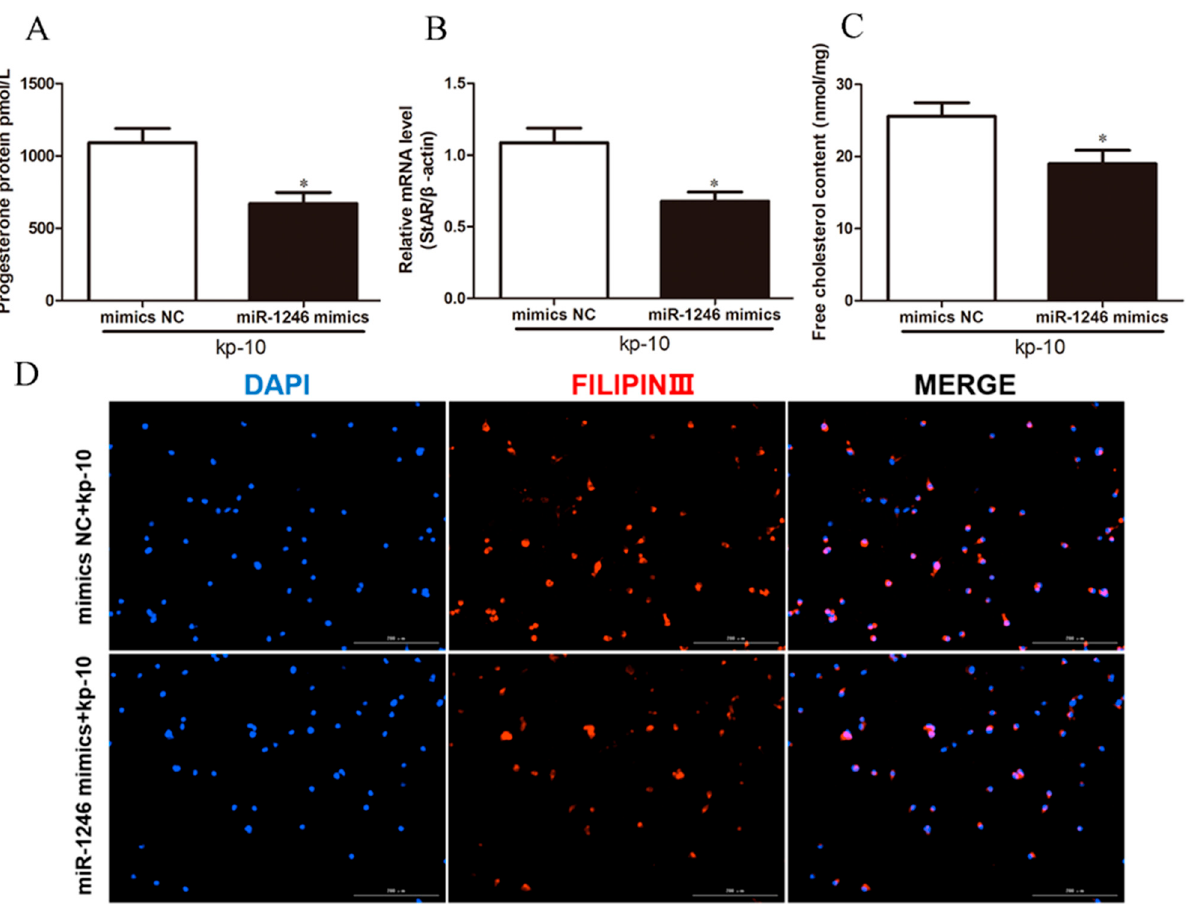
Figure 4. Overexpression of miR-1246 attenuated the accelerative effect of kp-10 on P4 synthesis of BGCs. ( A ) The level of P4 in BGCs. ( B ) Relative StAR mRNA expression in BGCs. ( C ) Representative filipin staining of BGCs. ( D ) Relative free cholesterol content in BGCs. Mimics NC, negative control of miR-1246 mimics; miR-1246 mimics, overexpression of miR-1246. All data were presented as the mean ± SD ( n = 3), * p < 0.05.